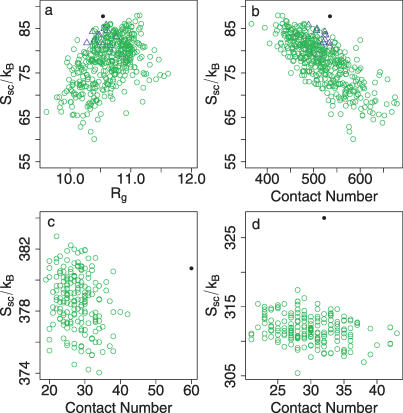
SCE of Native and Decoy Structures(A) SCE (Ssc) versus the radius of gyration (Rg).(B) SCE (Ssc) versus the number of residue contacts (Nc), for protein 1ctf and its decoys from the 4state_reduced decoy set.(C) SCE (Ssc) versus the number of interfacial contacts for protein–protein complex 1spb and its decoys.(D) SCE (Ssc) versus the number of interfacial contacts for protein–protein complex 1brc and its decoys.The black dot is the native structure, blue triangles (<2.0 Å RMSD to the native structure) and green circles (>2.0 Å) are decoy structures. The SCE of protein complexes are calculated using α = 0.7 (see Methods).